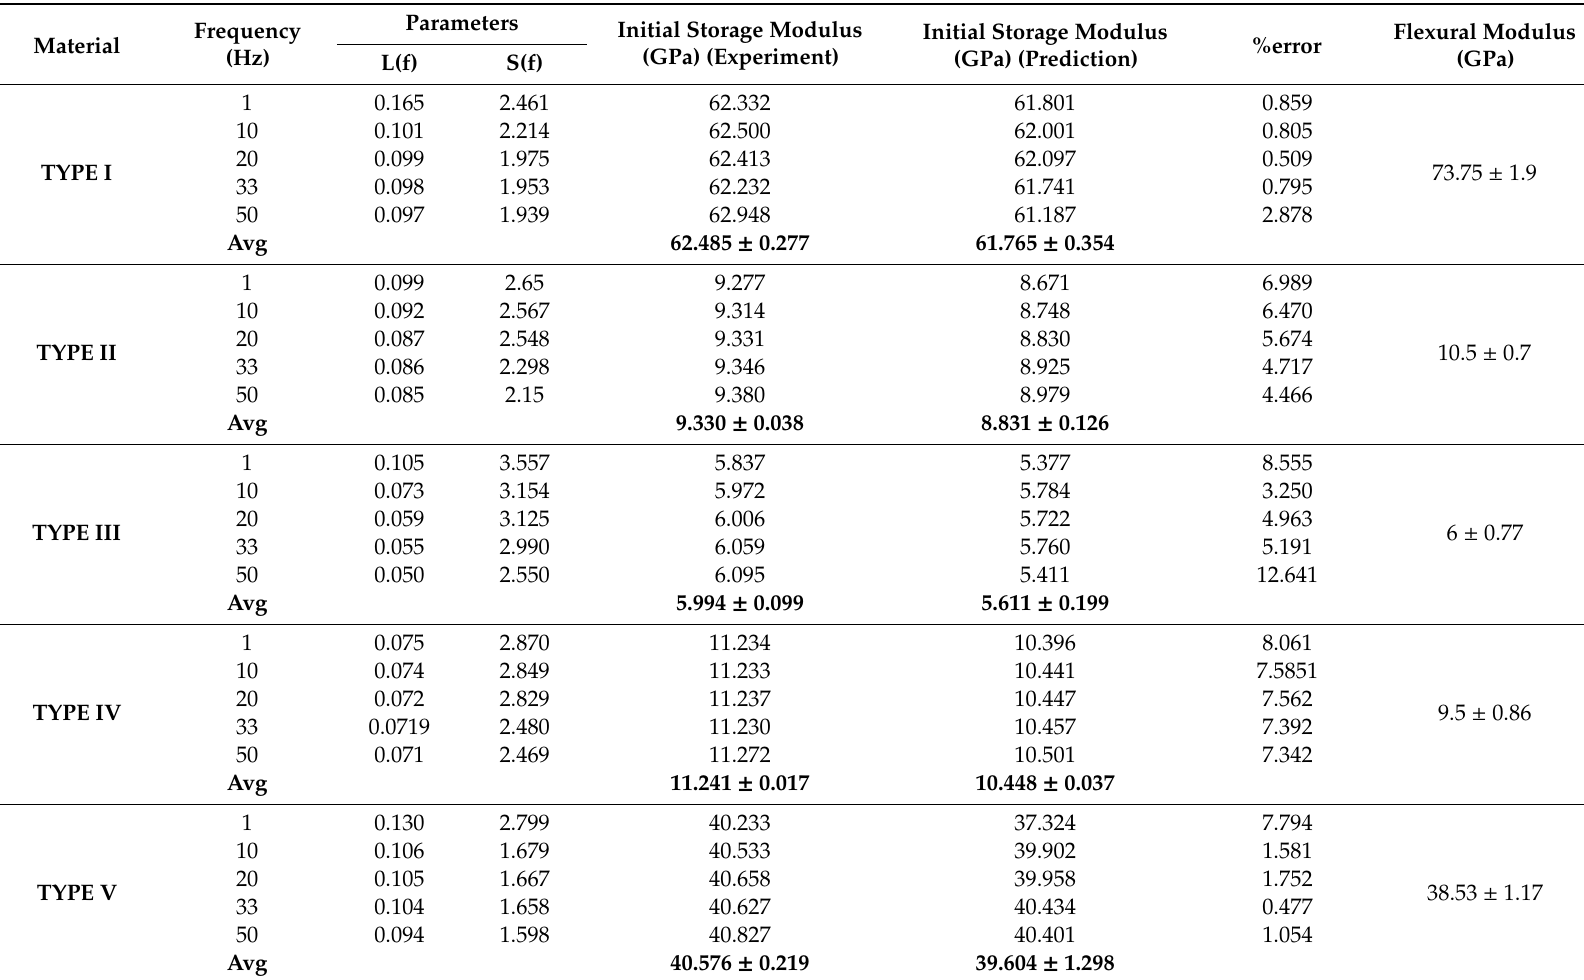
Table 2. The e ff ect of frequency on initial storage modulus of carbon / epoxy